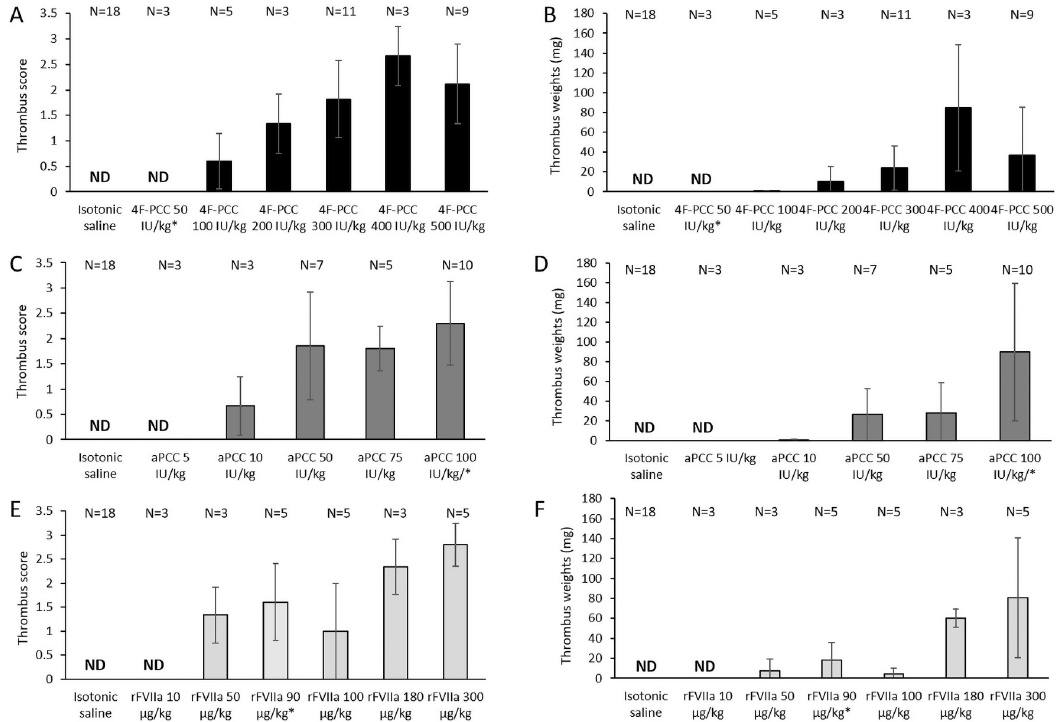
Fig 2. Thrombus score and thrombus weight: Dose-response for 4F-PCC, aPCC, and rFVIIa. (A) 4F-PCC thrombus score; (B) 4F-PCC thrombus weight; (C) aPCC thrombus score; (D) aPCC thrombus weight; (E) rFVIIa thrombus score; (F) rFVIIa thrombus weight. Data for venous stasis-induced thrombosis 10 minutes after the end of PCC, aPCC or rFVIIa infusion. Figure shows mean (standard deviation). � indicates a therapeutic dose.